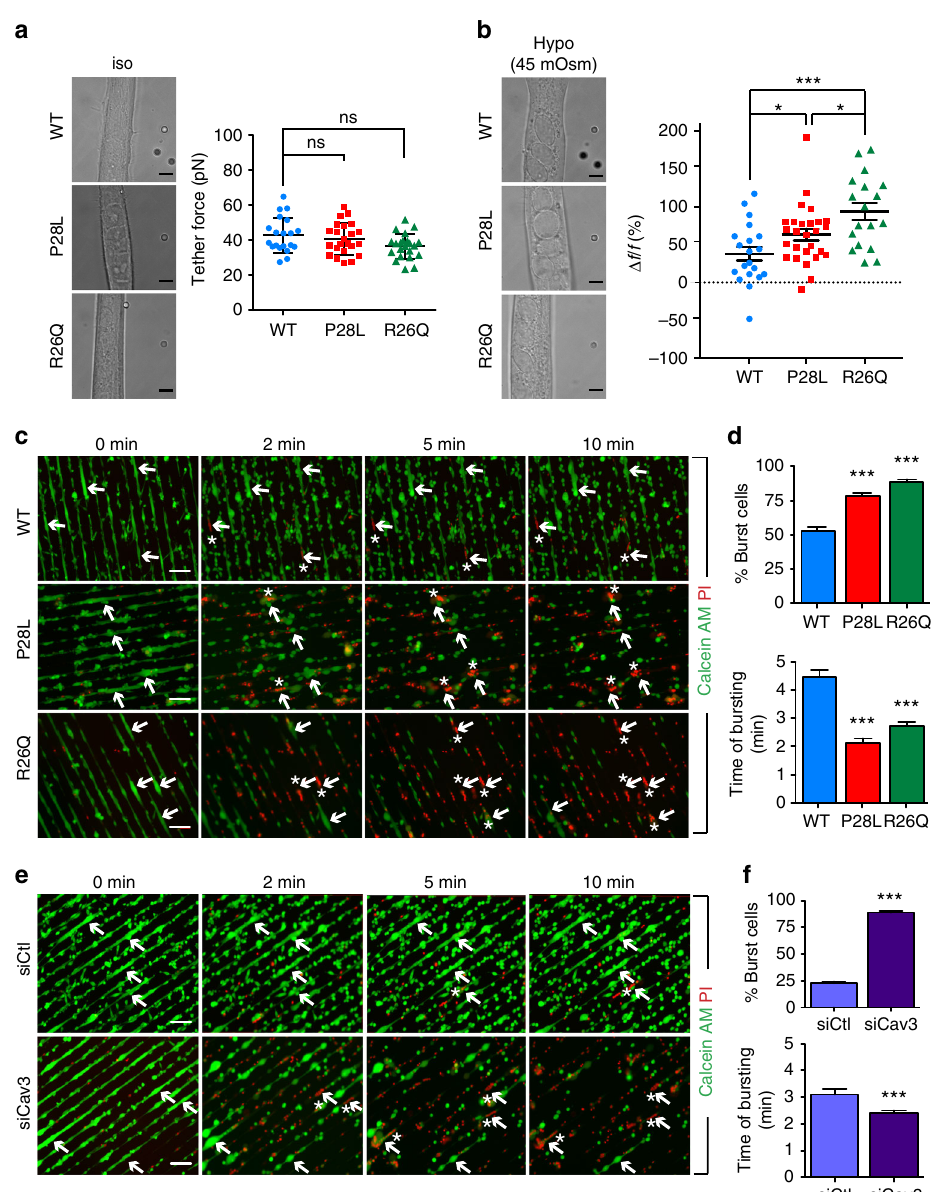
Fig. 2 Cav3 mutant myotubes present major defects in membrane tension buffering and integrity. a , b Membrane tension measurement analysis using optical tweezers and nanotube pulling on micropatterned WT, Cav3 P28L, or Cav3 R26Q myotubes. Membrane tethers were pulled in the perpendicular axis of aligned myotubes after micropatterning in resting conditions and 5 min after a 45 mOsm hypo-osmotic shock ( a , b , left panels). Membrane tension was analyzed in resting condition ( a , right panel) and the difference of membrane tension before and after hypo-osmotic shock was calculated, re fl ecting the percentage of increase of membrane tension upon mechanical stress ( b , right panel). c , e Micropatterned WT, Cav3 P28L, or Cav3 R26Q myotubes ( c ) or WT ctl (siCtl) and Cav3-depleted (siCav3) myotubes ( e ) were loaded with calcein-AM (green). The medium was switched with a 30 mOsm medium supplemented with propidium iodide (PI, red). Representative pictures were taken at the indicated times during hypo-osmotic shock. Arrows correspond to myotubes and asterisks correspond to burst myotubes. d , f Quanti fi cation of the percentage of burst myotubes (upper panel) and mean time of bursting in minutes (lower panel) in c and e , respectively. a , b Scale bar = 5 µ m. c , e Scale bar = 120 µ m. Reproducibility of experiments: a Representative pictures and quanti fi cations from 7 independent experiments (WT n = 20 cells, P28L n = 23 cells, and R26Q n = 22 cells). b Representative pictures and quanti fi cations from 7 independent experiments (WT n = 20 cells, P28L n = 27 cells, and R26Q n = 18 cells). c Representative data of 3 independent experiments quanti fi ed in d (% burst cells: WT n = 310 cells, P28L n = 299 cells, and R26Q n = 271 cells; mean time of bursting: WT n = 165 cells, P28L n = 233 cells, and R26Q cells n = 240 cells). e Representative data of 3 independent experiments quanti fi ed in f (% burst cells: siCtl n = 749 cells and siCav3 n = 569 cells; mean time of bursting: siCtl n = 171 cells and siCav3 n = 506 cells). a , d , f Mean value ± SD. b Mean value ± SEM. a , b Statistical analyses were done using Kruskal – Wallis test. d , f Statistical analysis with two-tailed unpaired t test; * P < 0.05; *** P <